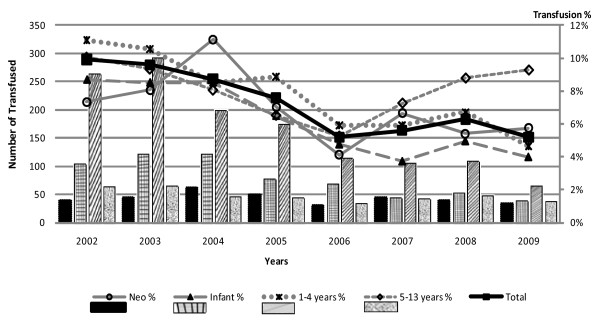
Numbers of children receiving a blood transfusion by year and age group.